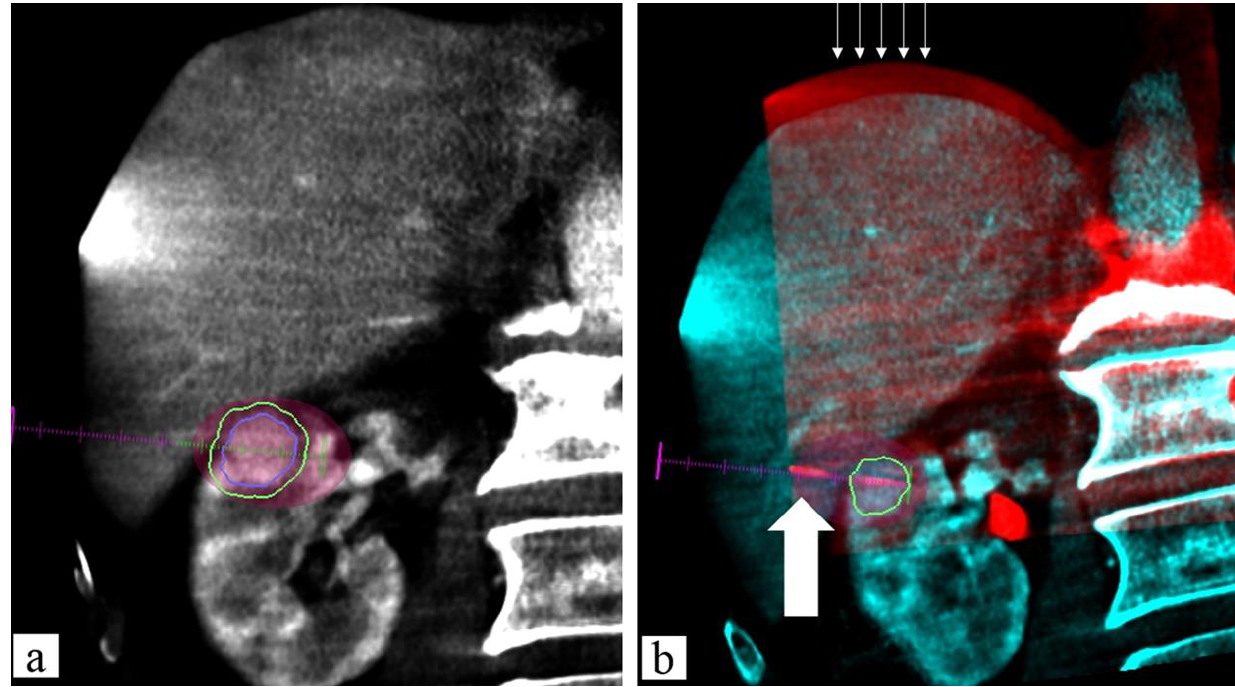
Figure 6. Eighty-three-year-old male, renal clear cell carcinoma biopsy-proven: MWA ablation. ( a ) Contrast-enhanced (c.e.) pre-procedural CBCT planning: lesion segmentation (blue line) and adding 5 mm safe margins (green line) with MW virtual probe with predicted ablation area (manufacturer specific) overlaying to segment; ( b ) fused images obtained using c.e. preprocedural CBCT and non-enhanced intra-procedural CBCT: MW probe (white wide arrow) placement with all lesions covered by the predictable ablation area. Thin white arrows show the mismatch overlay on the diaphragm plane between the two CBCT images due to different breath holding.